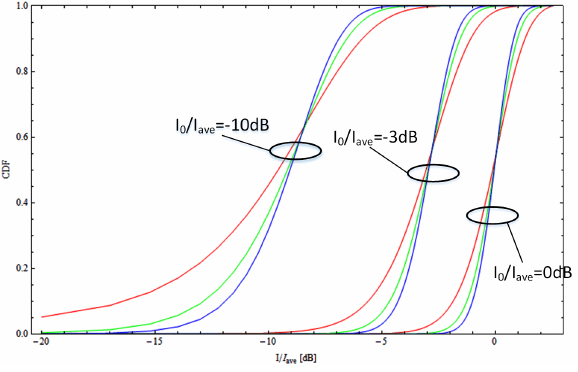
Figure 4. Realized interference distributions for three different I 0 / I ave dB, vs . realized interference powers I / I ave . Interference contribution from J = 1, 2, 3 independent sources. The distribution with J = 1 in red is widest and with J = 3 in blue most narrow for all values of I o / I ave